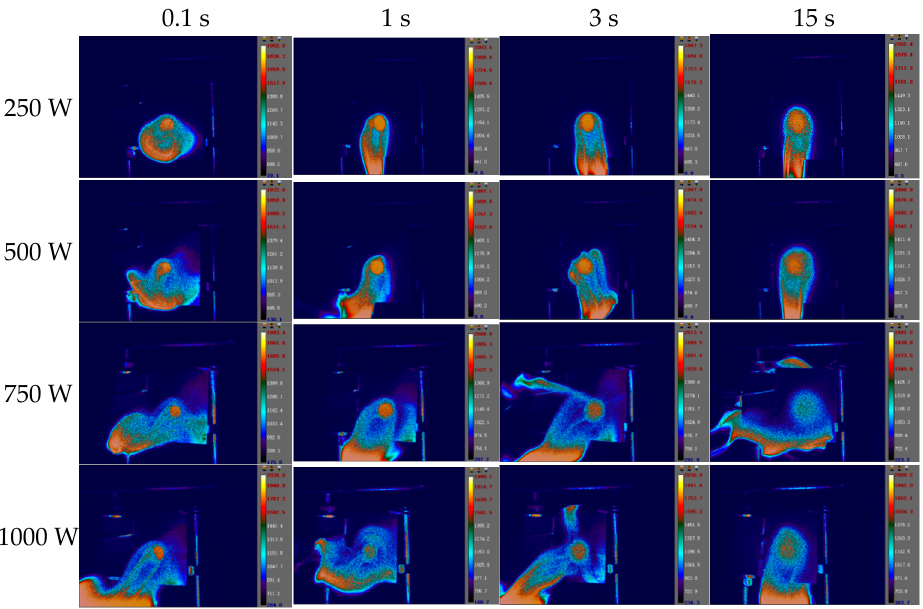
Figure 14. The images of the temperature field on the CFRP laminated front surface irradiated by different laser power in the air environment with different time.